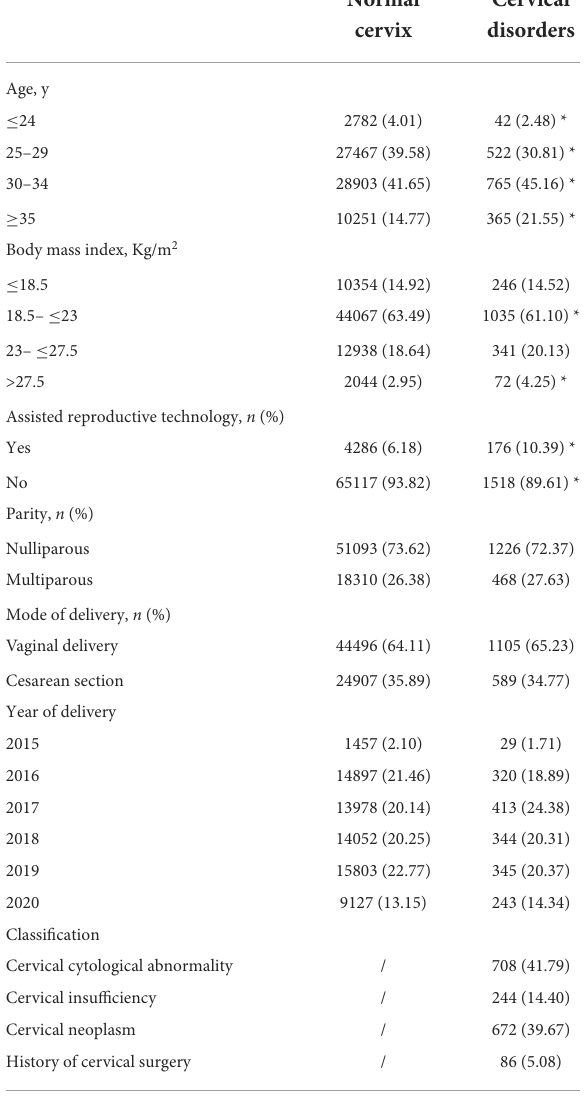
TABLE 1 Basic characteristics of the study population by cervix. Normal Cervical